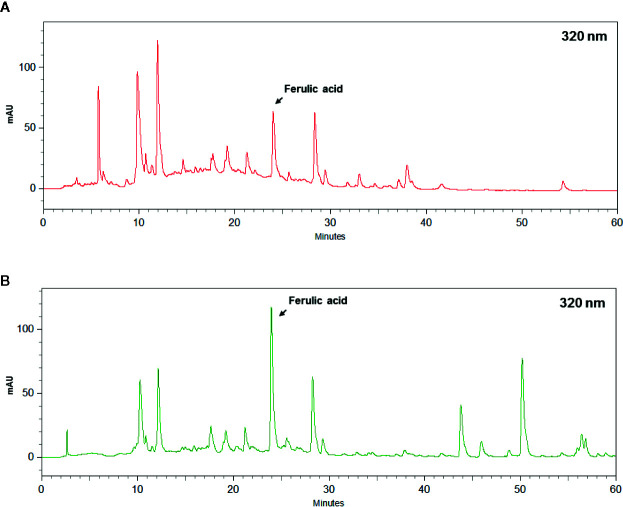
HPLC chromatogram of ferulic acid in (A) Si-Wu-Tang (SWT)-water decoction (WD) and (B) SWT-concentrated herbal extract (CHE).